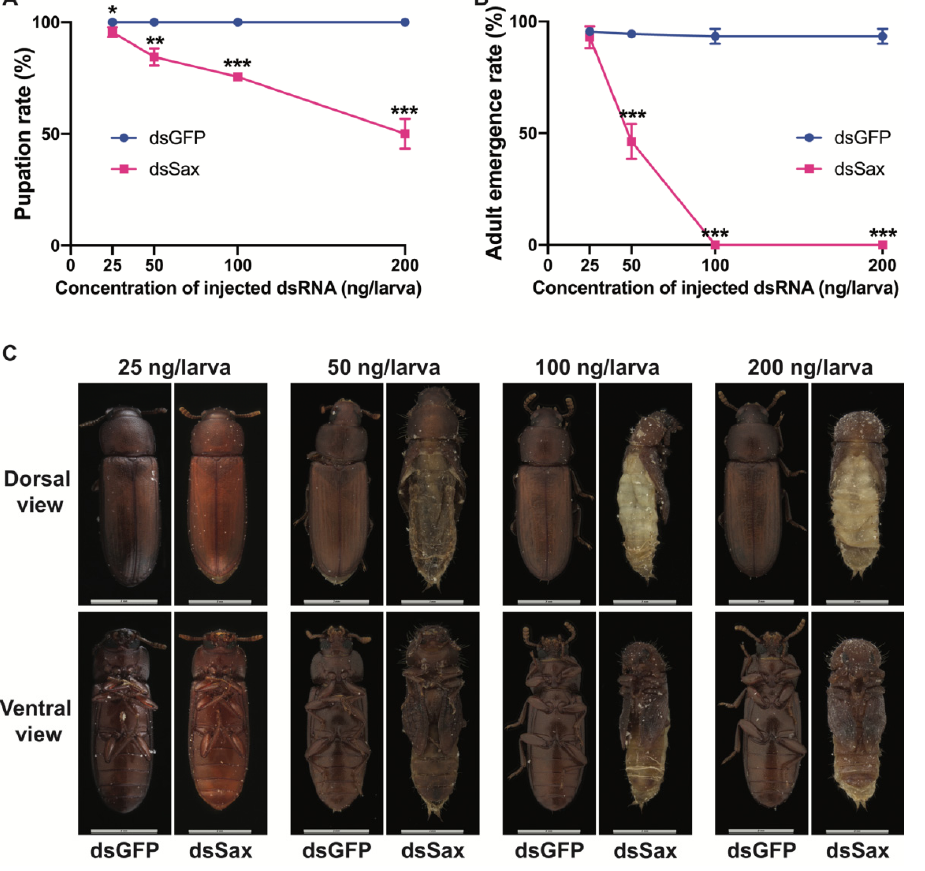
Figure 5. Effects of Sax RNAi on the pupation rate, adult emergence rate and phenotype. ( A ) Pupation rate in different doses of dsGFP and dsSax-treated groups. ( B ) Adult eclosion rate in different doses of dsGFP and dsSax-treated groups. ( C ) The phenotype of adults or failed emergence of adults from different doses of dsGFP and dsSax groups. Asterisks above bars indicate significant differences between the treatment and corresponding control, * p < 0.05, ** p < 0.01, *** p < 0.001 by t -test.